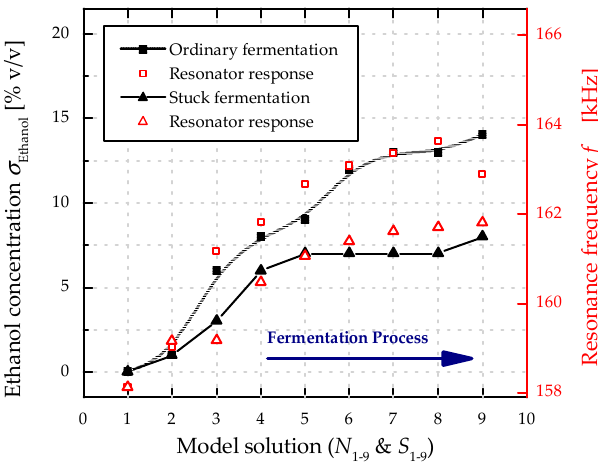
Figure 9. Twelve-mode frequency response analysis of an ordinary ( N 1–9 ) and a stuck ( S 1–9 ) fermentation process in comparison to the nominal ethanol concentration of the investigated model solutions. The inserted lines serve as guide for the eye.